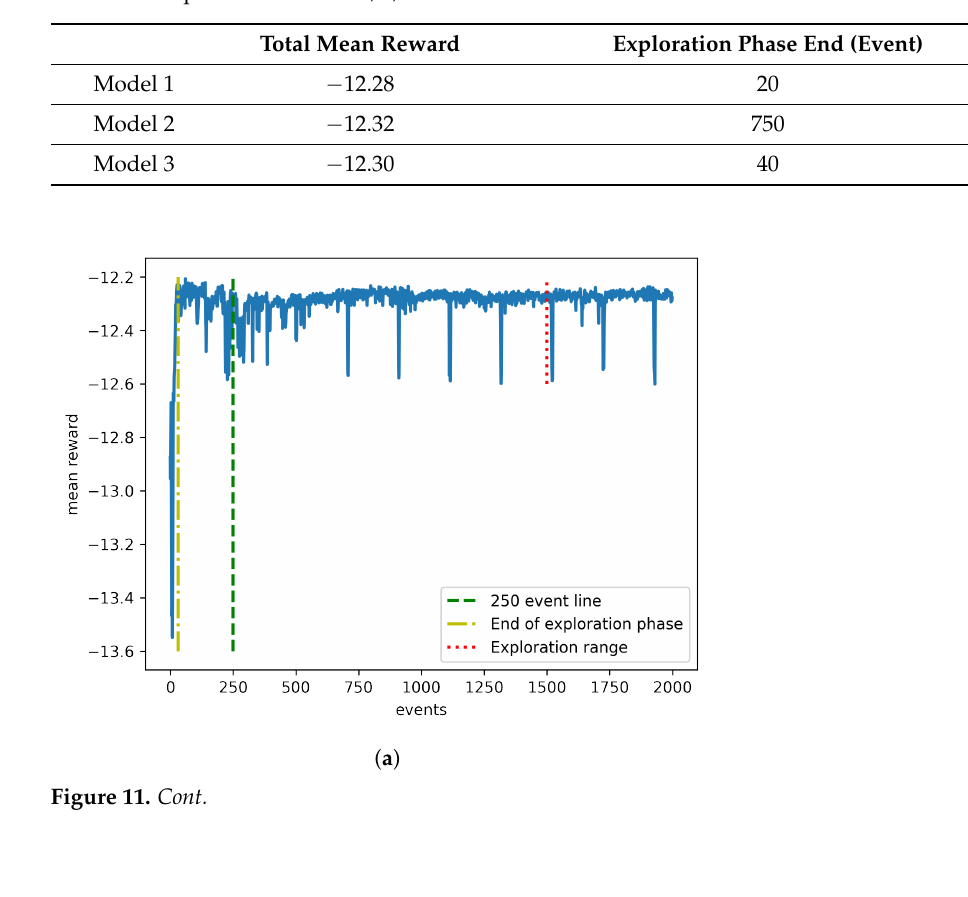
Figure 10. Reward returns for different DQN models with 2000 events and learning rate equal to 0.001. ( a ) Model 1 with one hidden layer 30 neurons, step size of 1000. ( b ) Model 2 with one hidden layer, step size of 500 and 100 neurons. ( c ) Model 3 with three hidden layers with 100, 60, and 30 neurons, respectively, and a step size of 500. ( d ) Model 4 has three hidden layers with 81, 212, and 29 neurons, respectively, and a step size of 500. Table 3. Comparison of Model 1, 2, and 3.